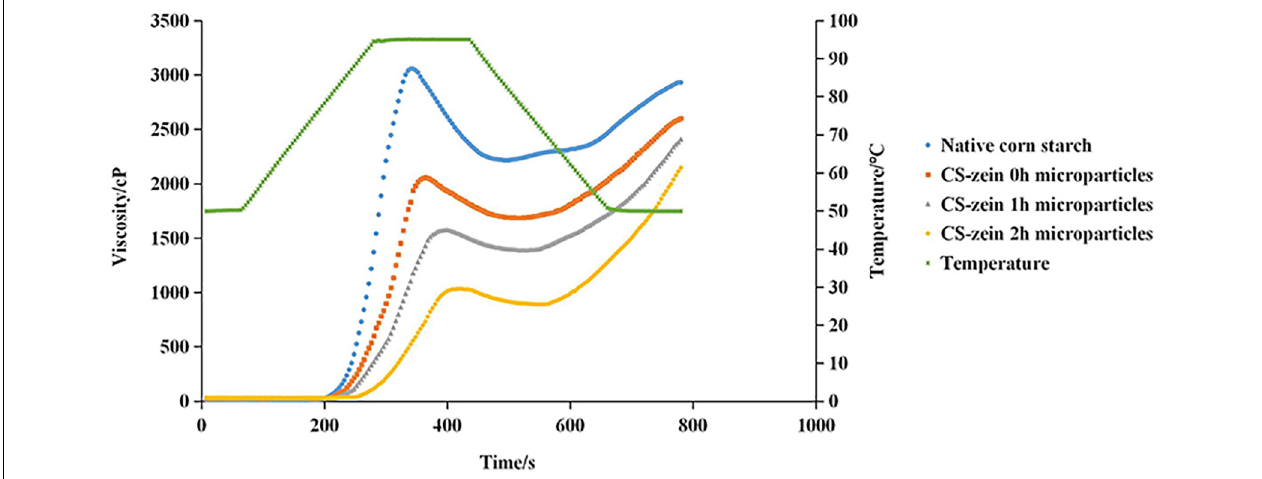
FIGURE 7 | RVA patterns of native corn starch and core-shell starch/zein microparticles crosslinked by TGase for different times (0, 1, and 2 h).